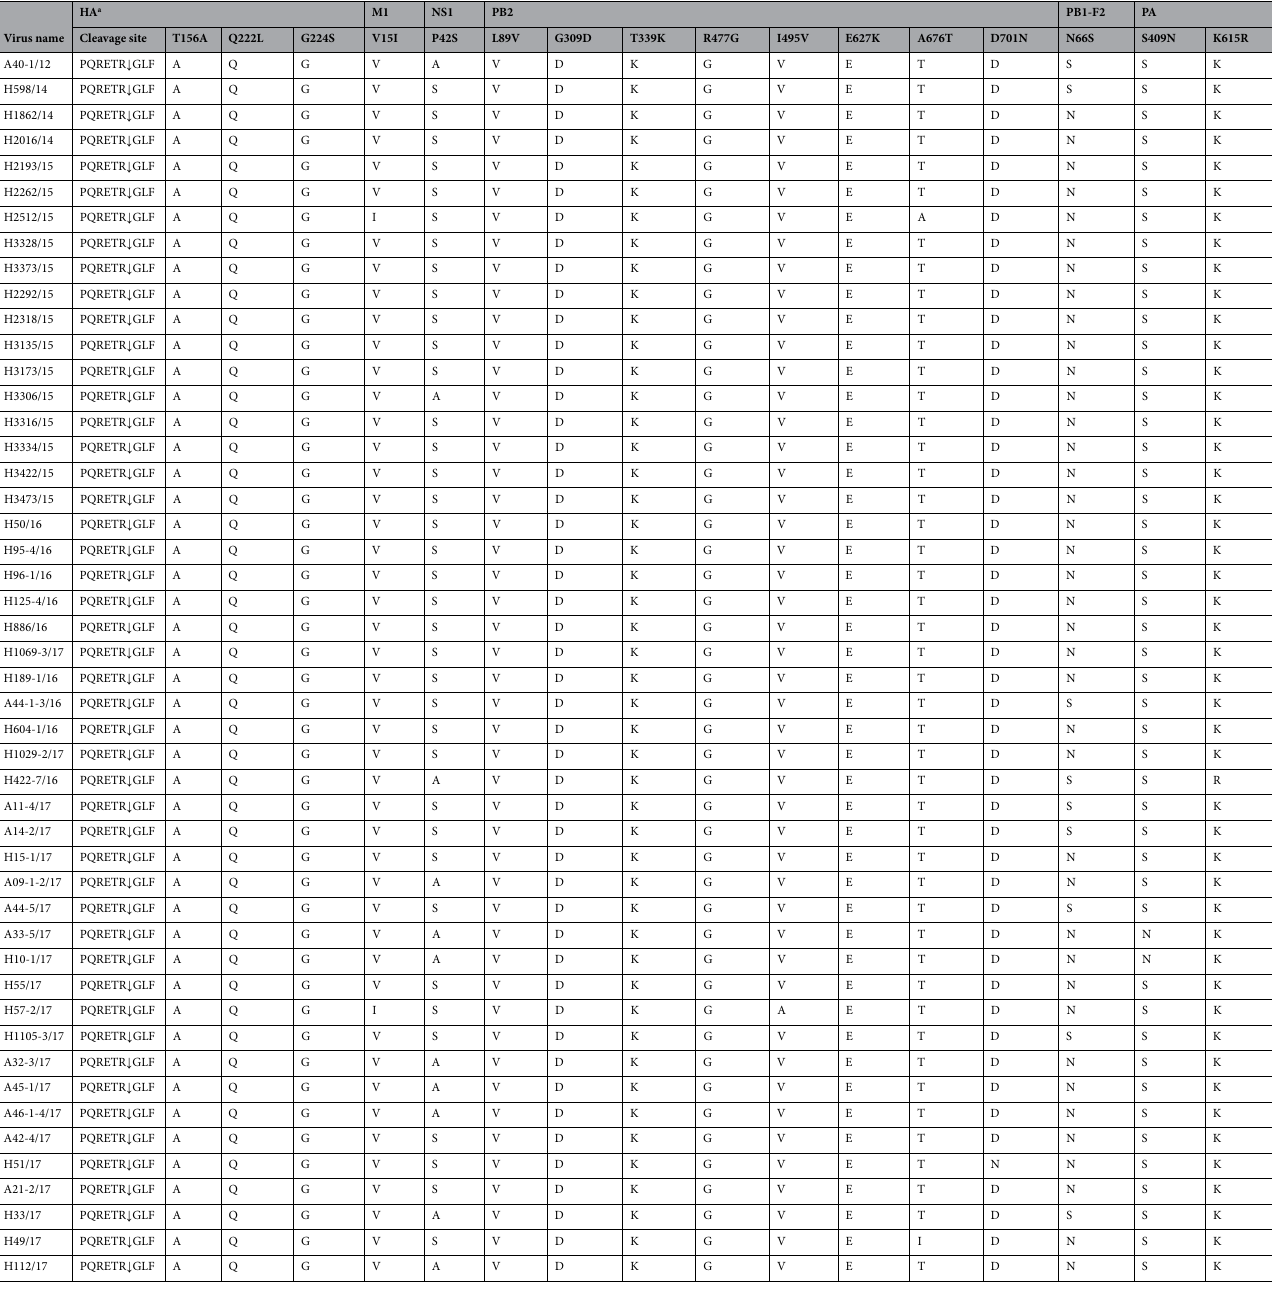
Table 2. Amino acid sequences and substitutions in H5 low pathogenic avian influenza viruses (LPAIVs) isolated from wild birds in South Korea between 2010 and 2017. a H5 numbering was used. HA,